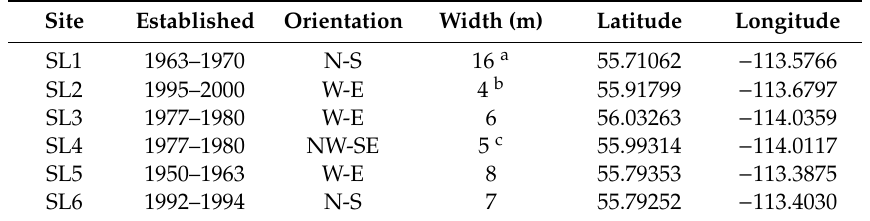
Table 1. Overview of research sites where treed peatlands are intersected by seismic lines.